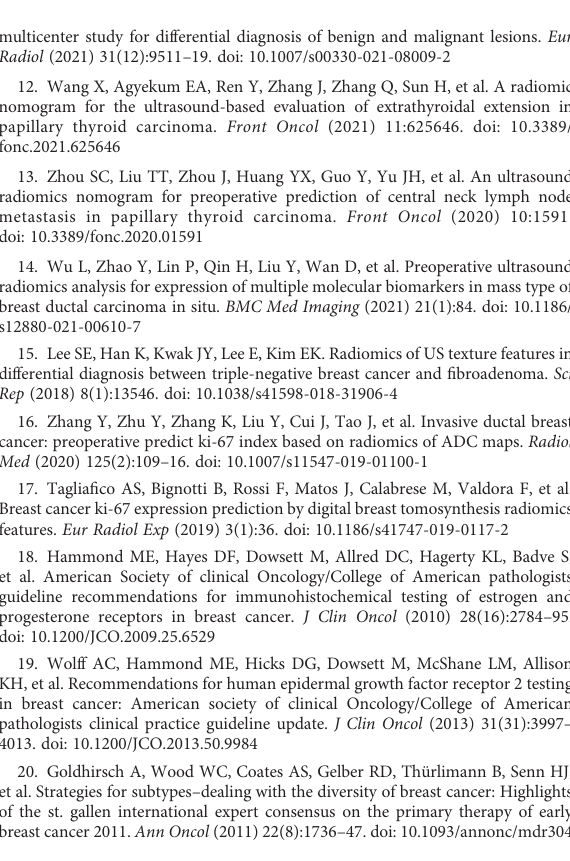
SUPPLEMENTARY FIGURE 1 Distribution of the 200 AUC values calculated by LGOCV algorithm in the test